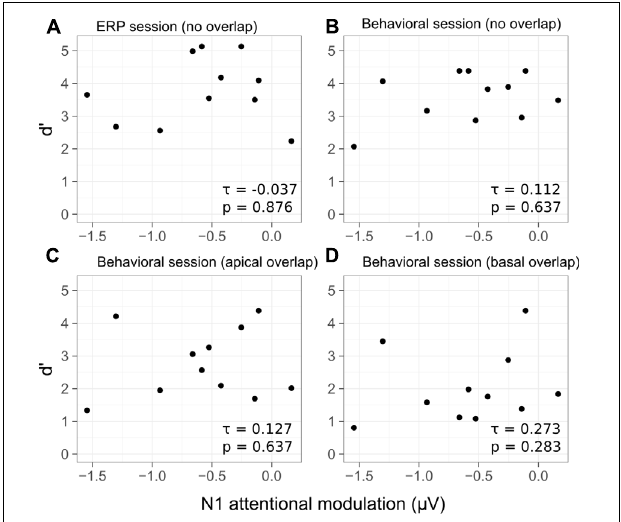
FIGURE 7 | Scatterplots of the d (cid:48) scores as a function of the average N1 attentional modulation for each listener and condition. Behavioral d (cid:48) scores from the ERP session are shown in (A) ( no overlap condition). The d (cid:48) scores from the behavioral session are shown in (B) for the no overlap condition, in (C) for the apical overlap condition and in (D) for the basal overlap condition. Kendall rank correlation coefficients and p -values are shown in the bottom-right corner of each